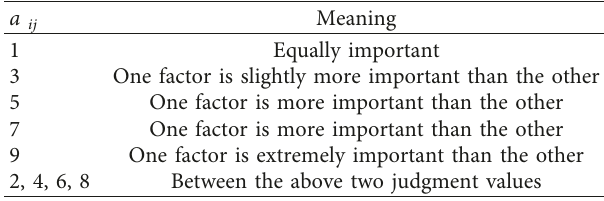
Table 1: Definition of importance.